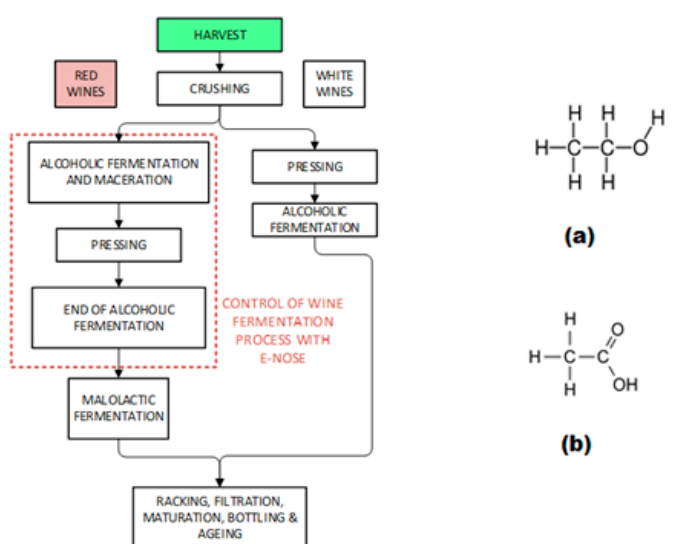
Figure 1. Flow chart of the wine process ( left figure). Chemical structure of ( a ) ethanol and ( b ) acetic acid ( right figure).